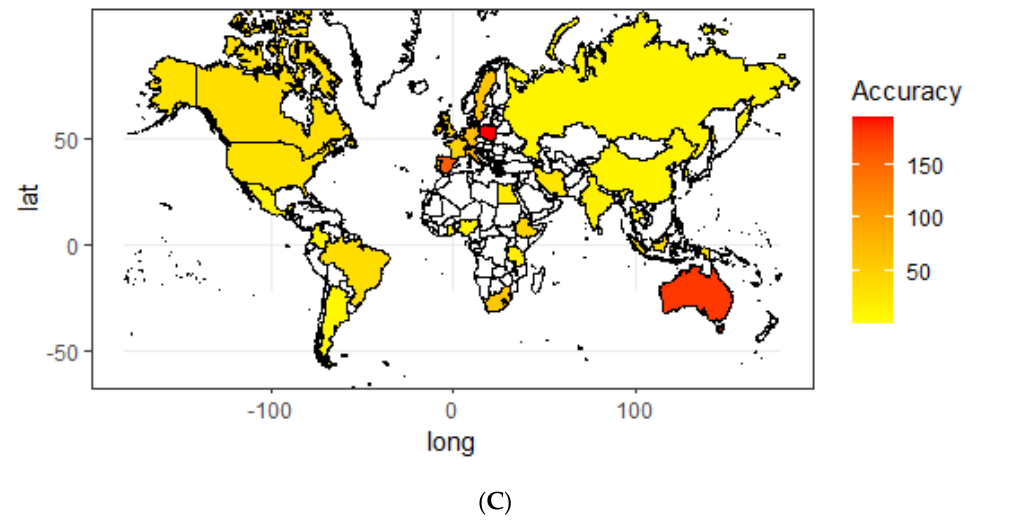
Figure 2. World map with the number of publications about MPs ingestion in freshwater fish ( A ), the number of species ( B ), and the number of specimens analyzed each species ( C ).